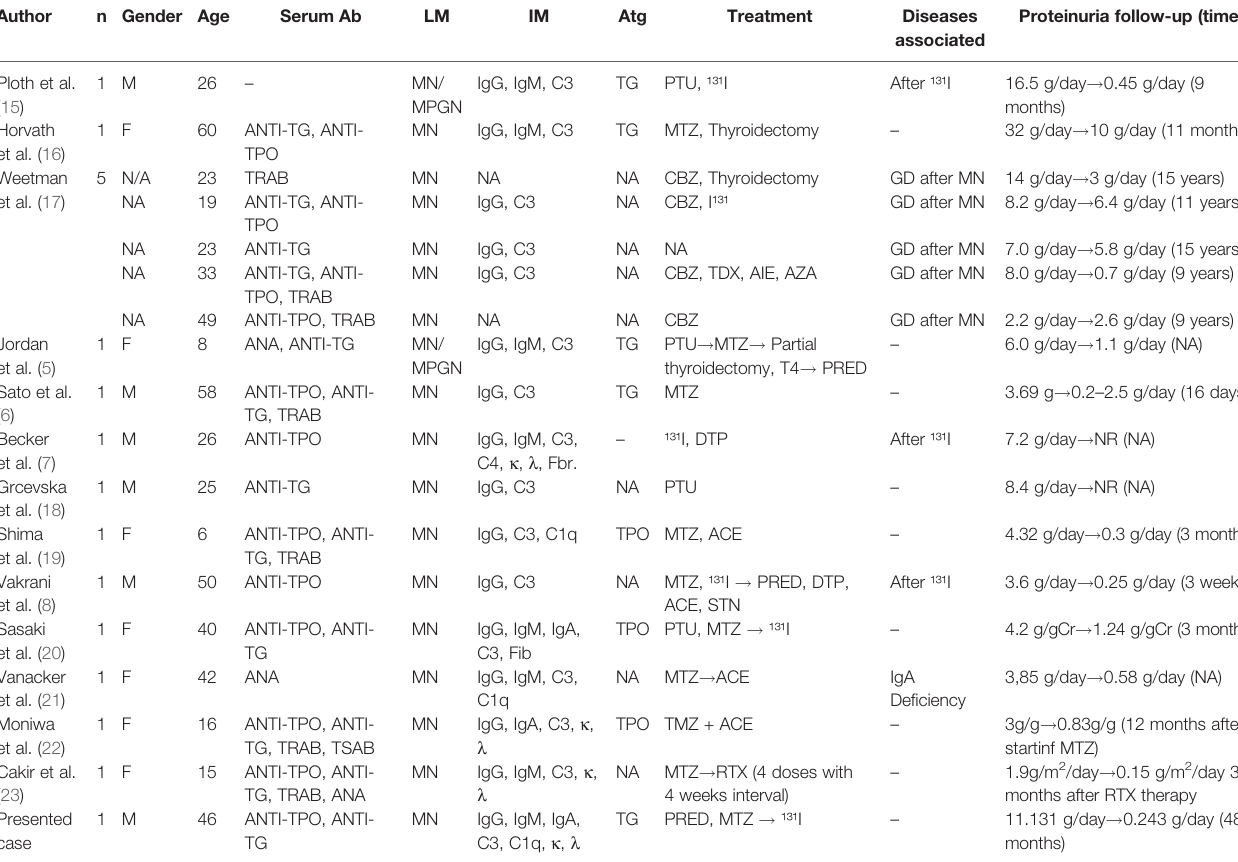
TABLE 2 | Literature review of cases with association of membranous nephropathy and Graves ’